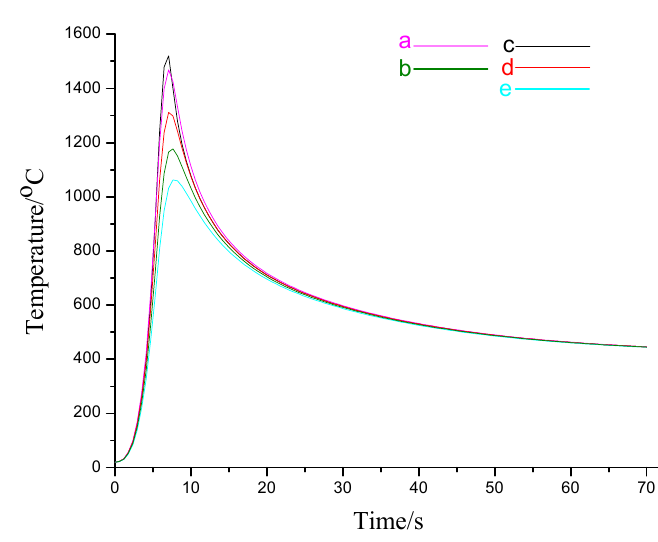
Figure 9. The thermal cycles of Points a, b, c, d and e in Figure 7.